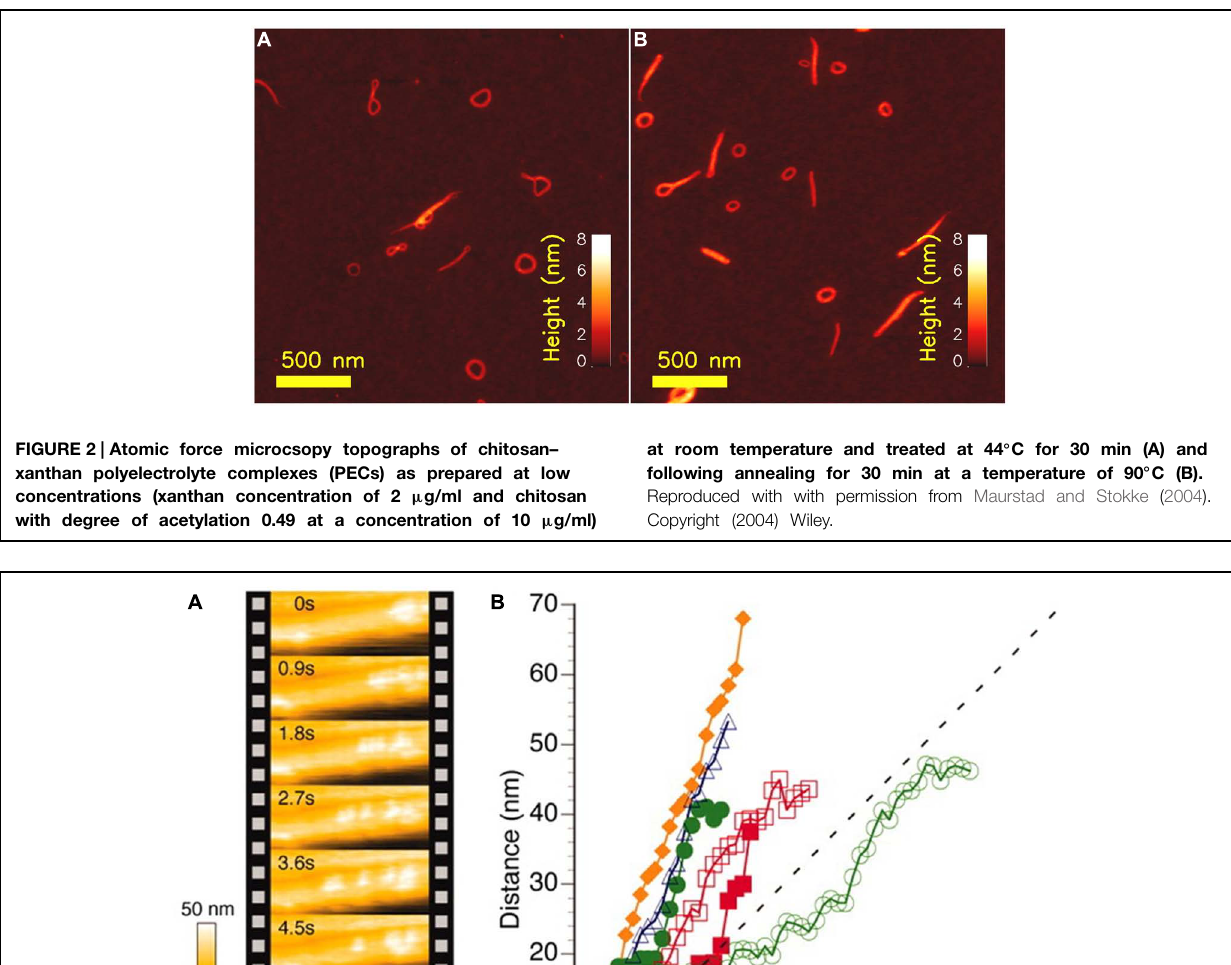
FIGURE 3 | High speed AFM imaging of Trocoderma reesei Cel7A cellulase acting on crystalline I α cellulose. (A) AFM topographs of the same area of the cellulose crystal imaged at intervals of 0.9 s revealing different localization of individual cellulases. (B) Time dependence from the initial position of individual cellulase positions when acting on